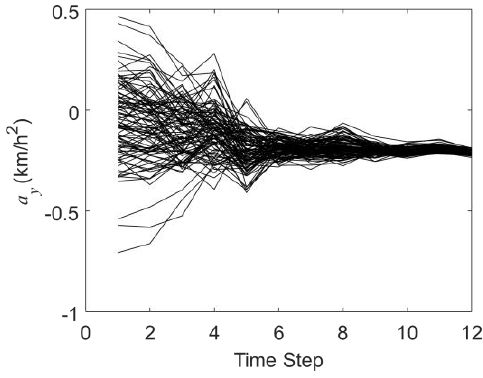
Figure 7. The history matching results of the acceleration in the X-direction ( a x ).